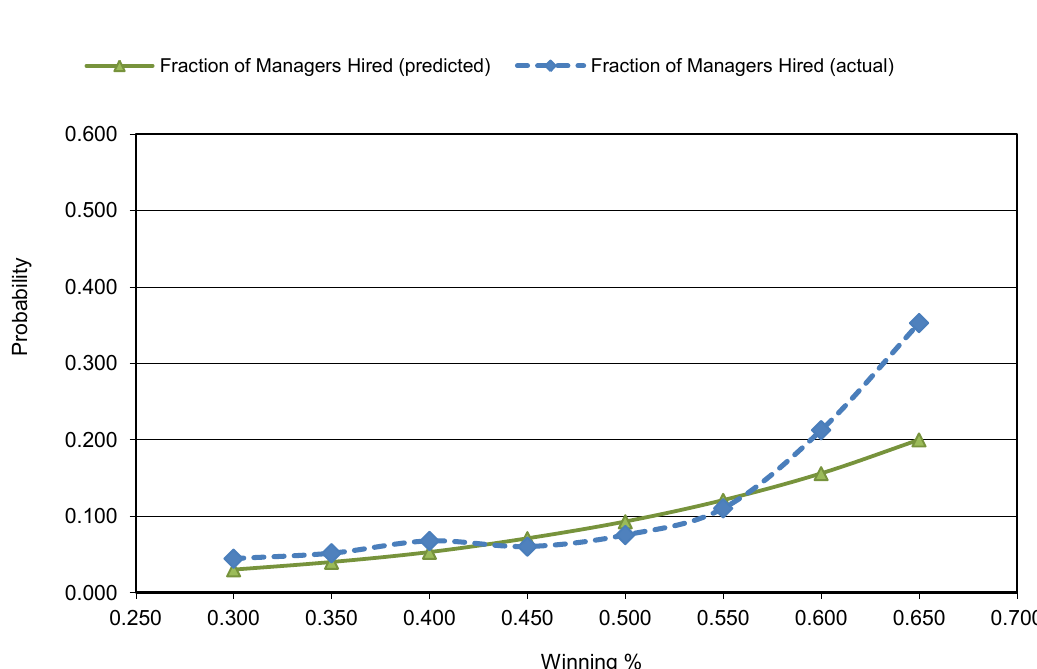
Figure 2: Probability that an ex–Major League Baseball manager will be hired.